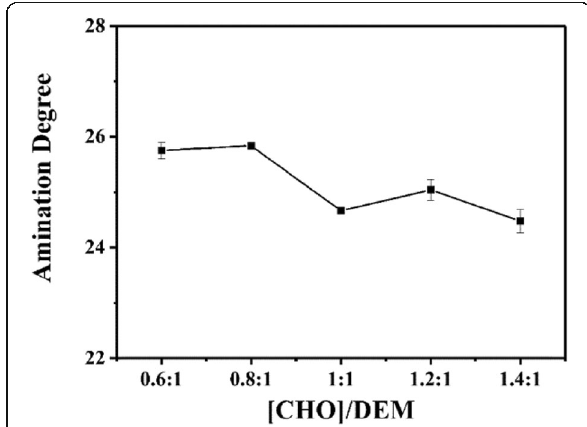
Fig. 2 The amination degrees of Mannich base polymers prepared under different ratio of